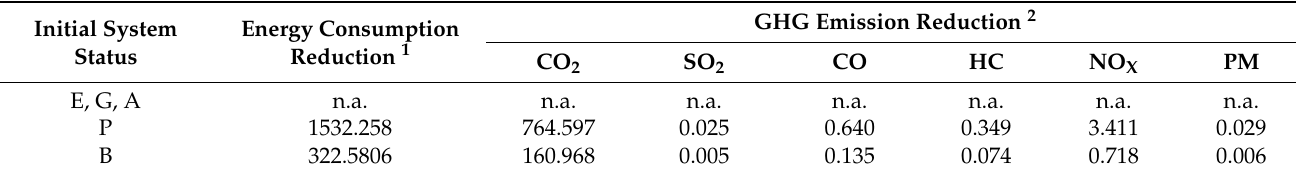
Table 11. Energy consumption reduction and GHG emission reduction resulting from the second iteration of maintenance policy optimization within the whole time-window of analysis in the case of natural gas electricity generation source.